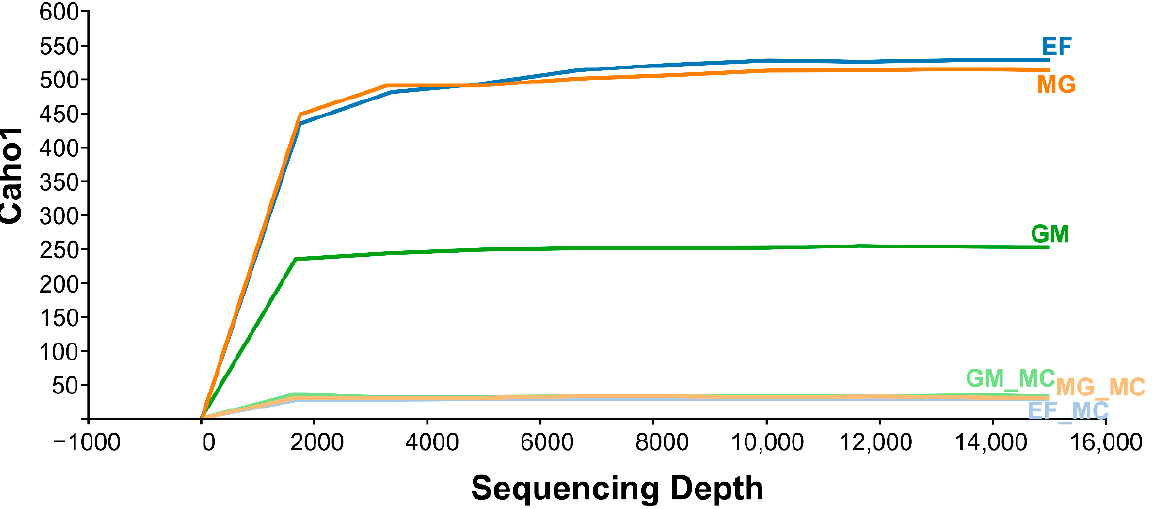
Figure 2. The rarefaction curve of Chao1 diversity indices of ASVs obtained from three laboratories, including the microbiome community of the analyzed marine sample (EF, GM and MG) and mock community control (EF_MC, GM_MC and MG_MC). Table 5. Classification rate summary (at least 97% sequence similarity) of the 16S rRNA metagenetic library at phylum level based on the following databases: Greengenes 515–806/Greengenes full- reference/SILVA 515–806/SILVA full-reference. Abbreviations: N—not